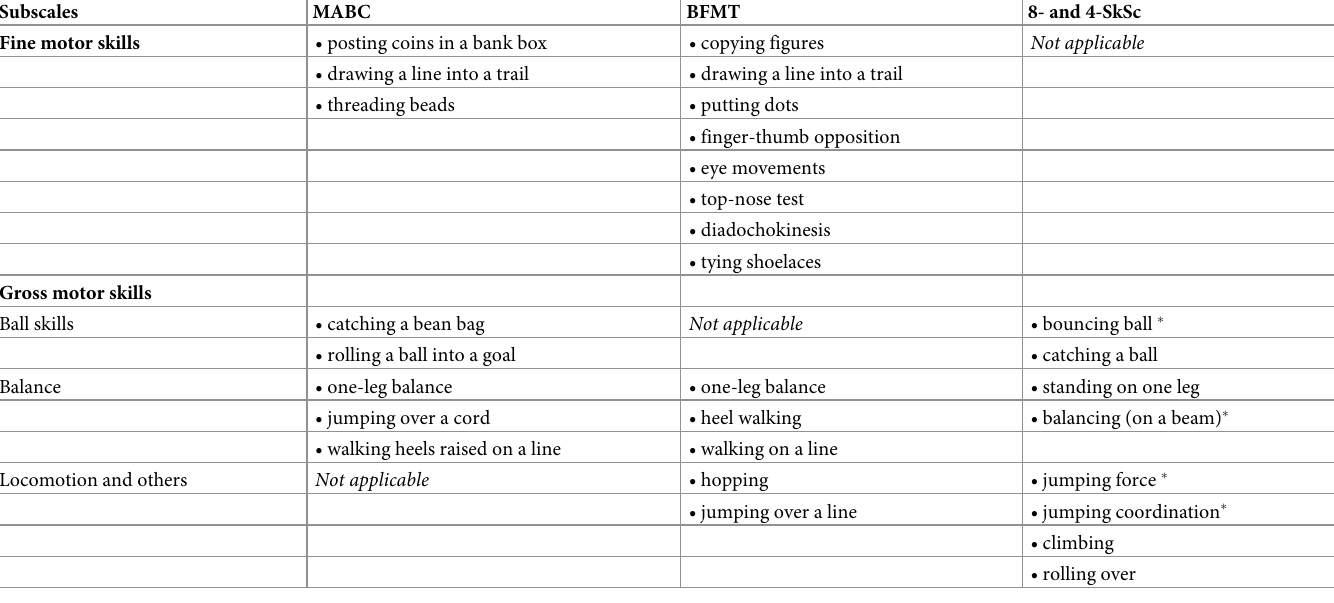
Table 1. The items of (the subscales of) the MABC, the BFMT and the 8- and 4-SkSc. Subscales MABC BFMT 8- and 4-SkSc Fine motor